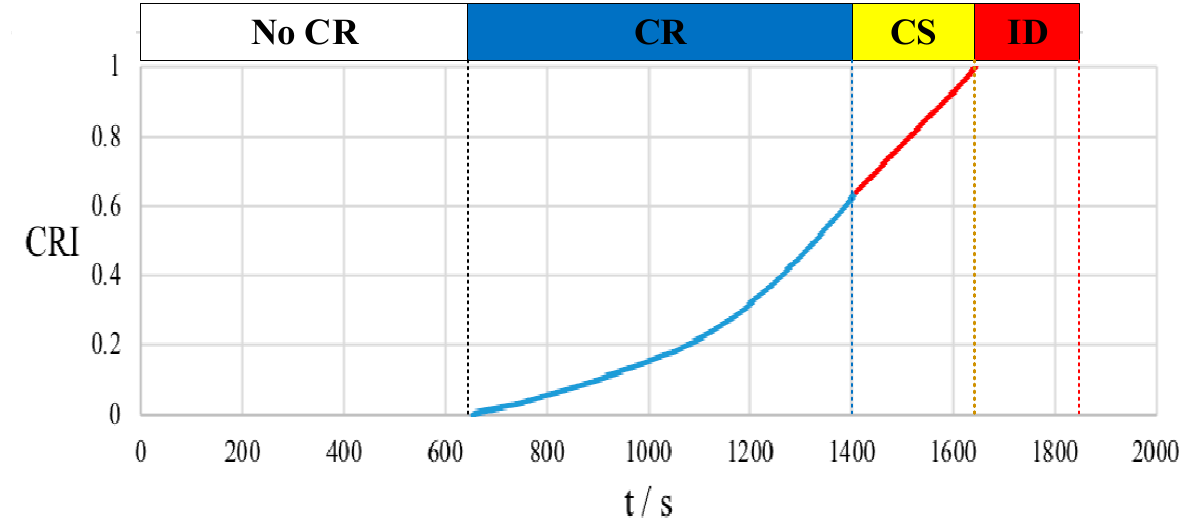
Figure 11. CRI for the stand-on vessel in a crossing situation.